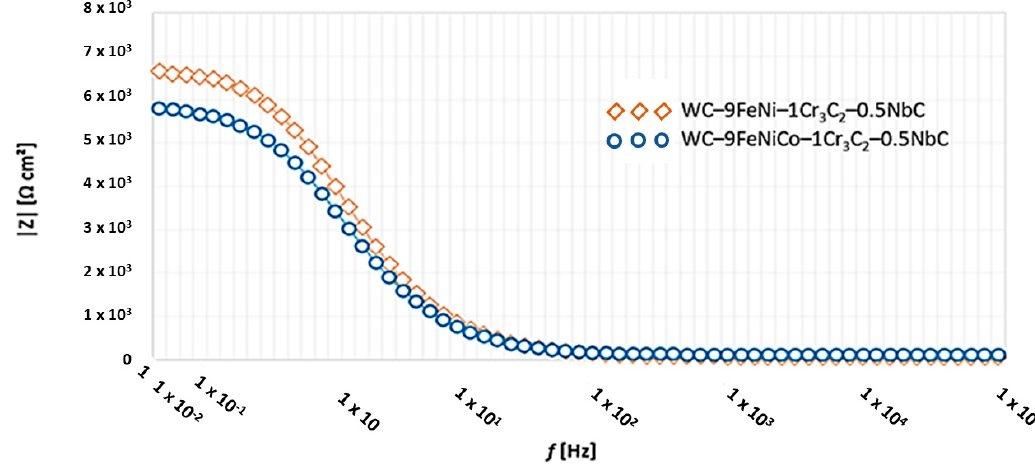
Figure 10. Bode plot of tested samples.